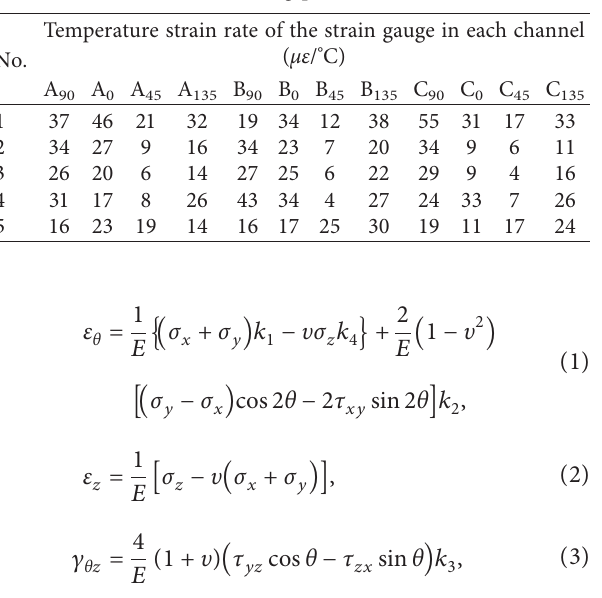
Table 2: The final stable strain value measured by each strain gauge at each measuring point. No.